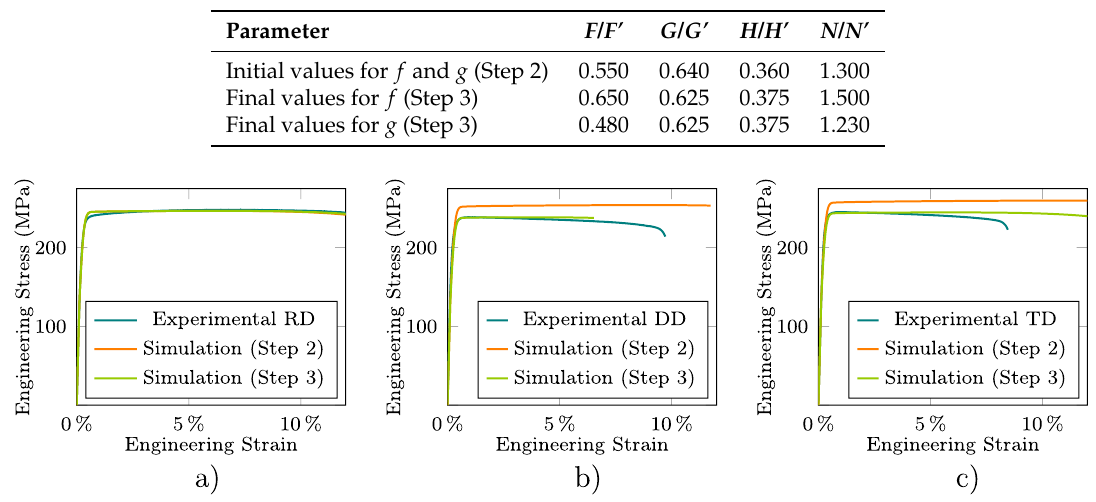
Table 3. Parameters of the Hill-48 yield and flow potential functions.